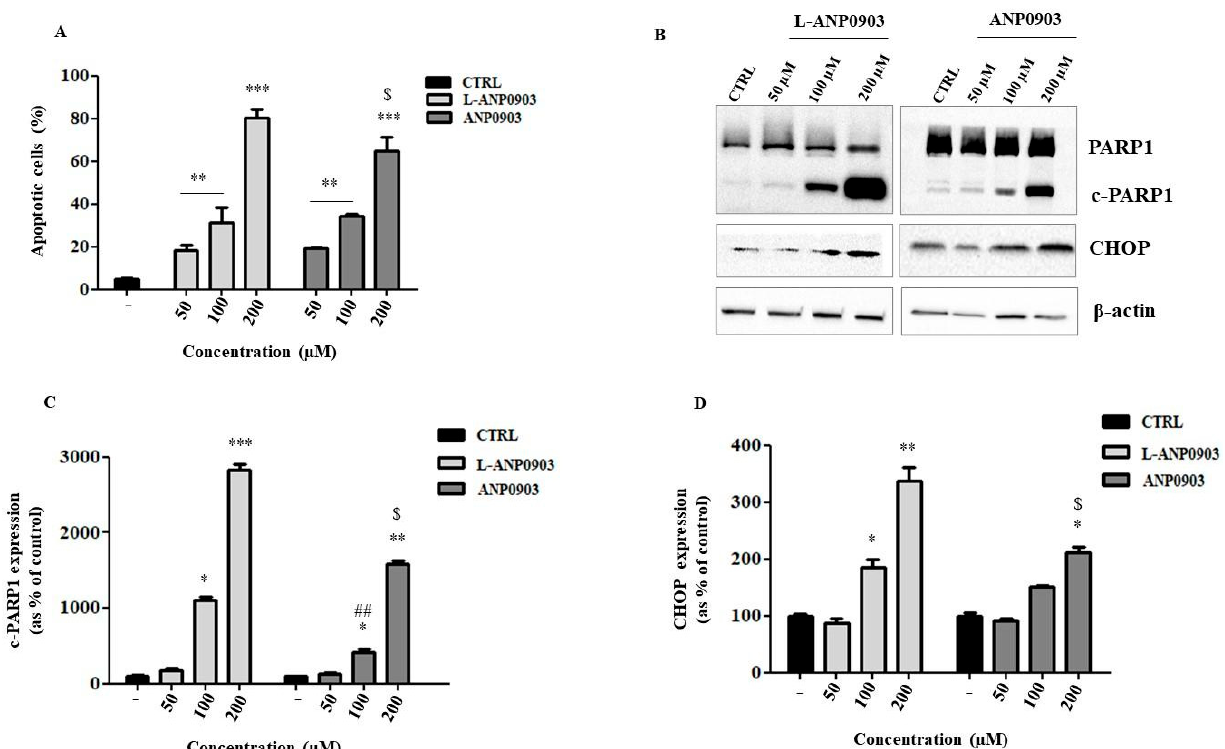
Figure 5. Apoptotic activity of ANP0903 and its liposomal formulation in HepG2 cells after 24 h of treatment. ( A ) FACS analysis. HepG2 cells treated with vehicle were used as negative control (CTRL). All data are expressed as means ± Standard Error (SE) of three experiments, each performed in triplicate, and statistical significance was evaluated by one-way ANOVA followed by Dunnett’s post hoc test or unpaired t -test ( B ). Representative Western blot. ( C , D ) Densitometric analysis of PARP1 cleavage and CHOP protein expression. Protein levels were presented as the fold change relative to control cells treated with vehicle (CTRL). β -actin was used as the loading control. Data are expressed as means ± Standard Error (SE) of three independent experiments. Kruskal–Wallis or Mann–Whitney nonparametric tests were performed; * p < 0.05, ** p < 0.01, *** p < 0.001 all samples vs. CTRL; ## p < 0.01 ANP0903 100 µ M vs. L-ANP0903 100 µ M and $ p <